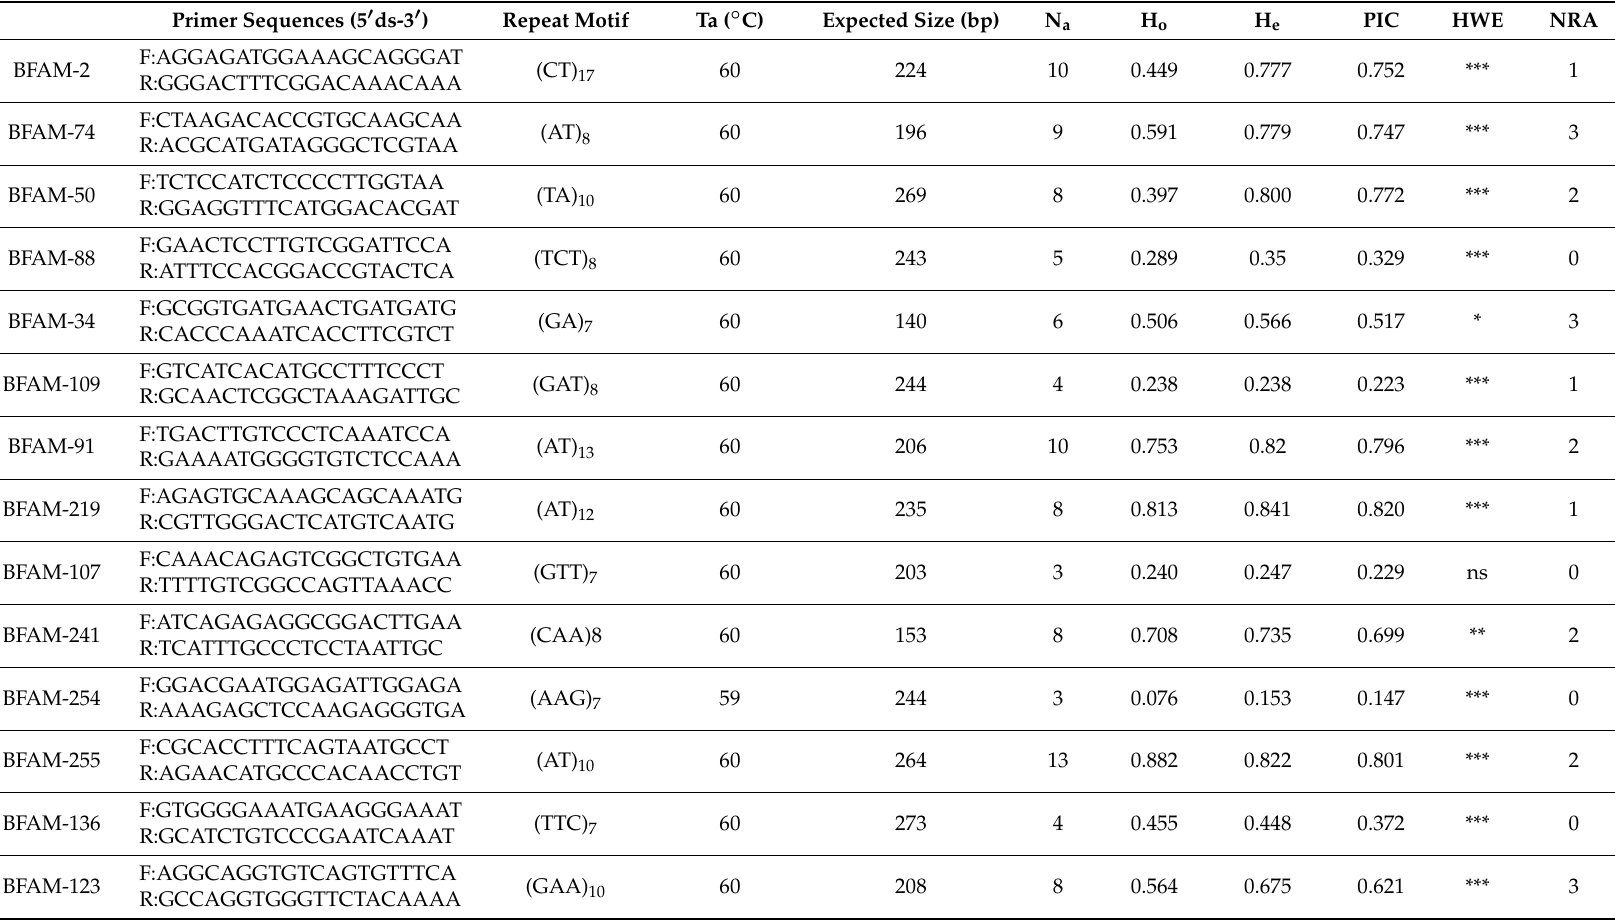
Table 2. Characterization of 19 polymorphic simple sequence repeats